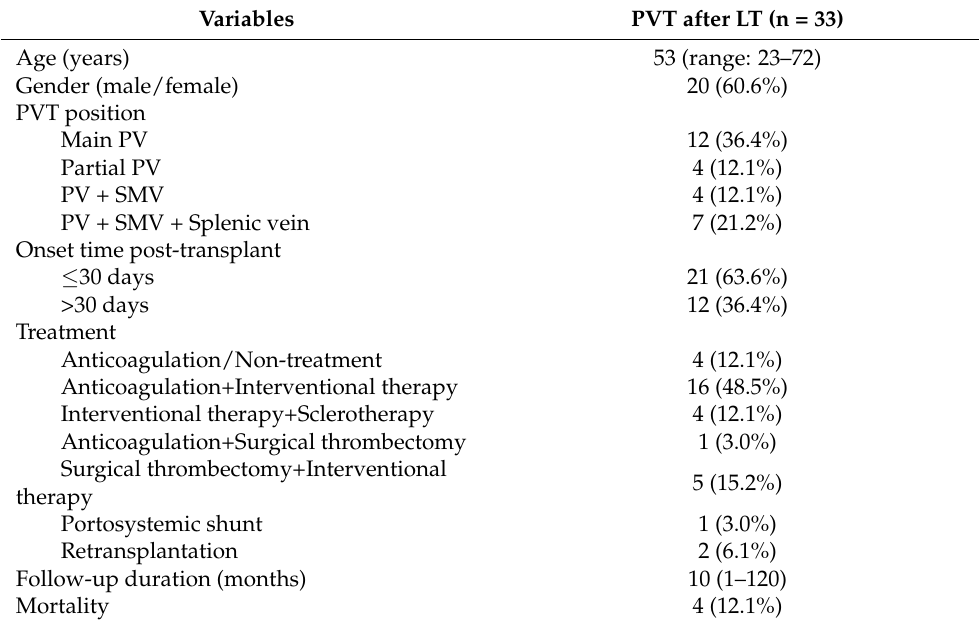
Table 3. Characteristics and treatment of reported cases of PVT after adult liver transplantation.